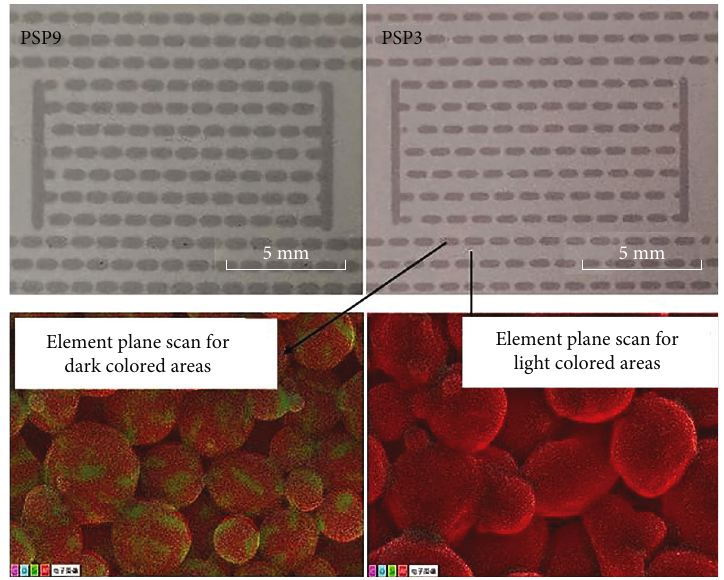
Figure 8: Sintering appearance and element distribution of the Al paste.